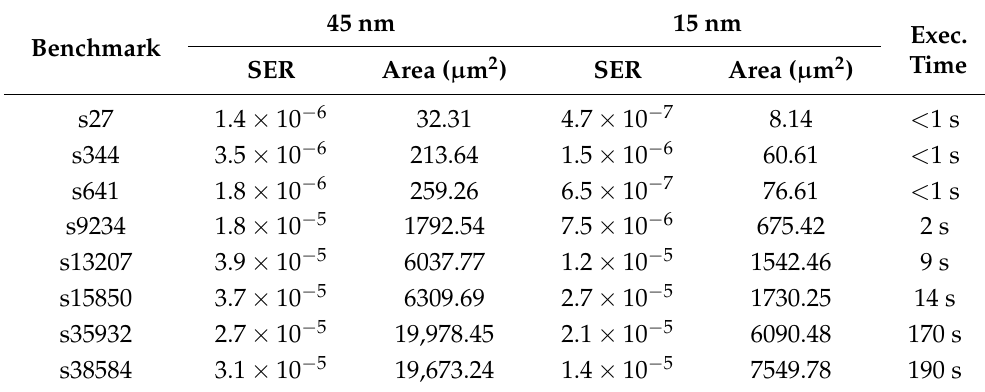
Table 7. SER evaluation of some benchmarks for the 45 nm and 15 nm